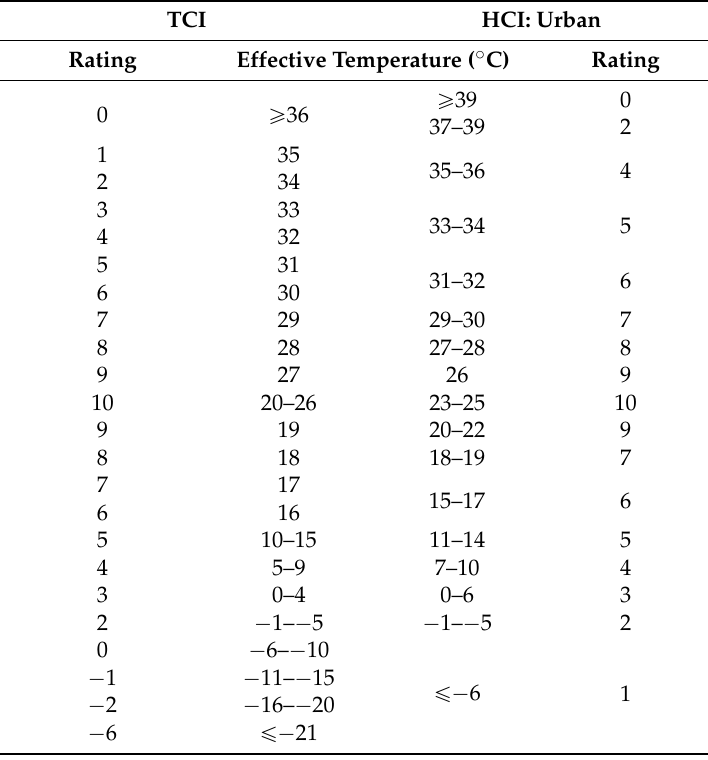
Table 3. Comparison of the thermal comfort rating system.